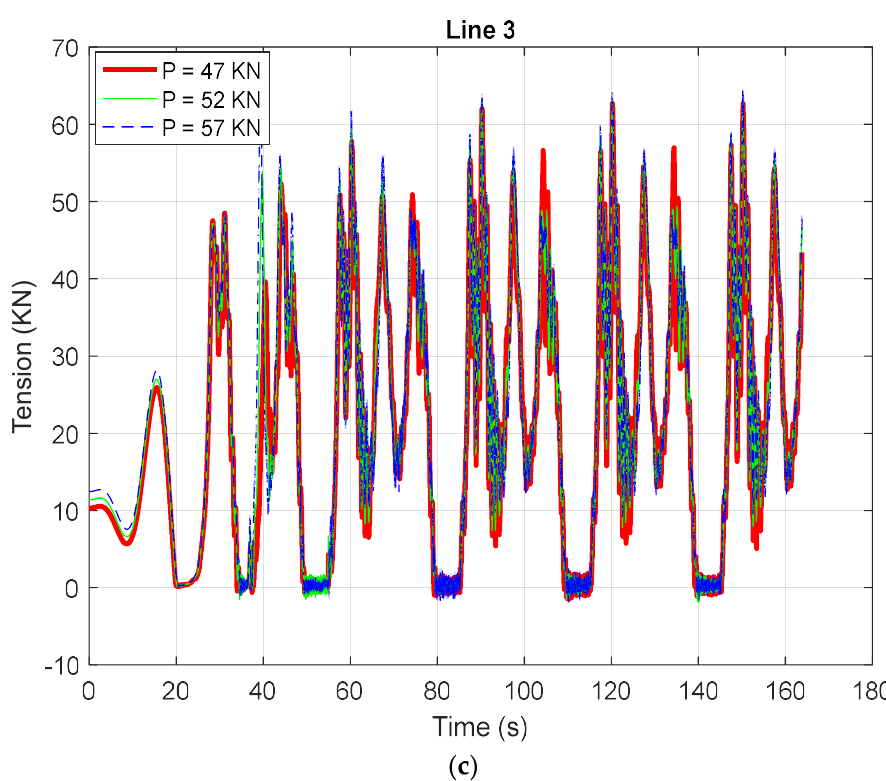
Figure 12. Time series of mooring tension at the fairlead with variations in pretension, ( a ) Line 1 ( b ) Line 2, ( c ) Line 3. Table 8. Comparison of mooring tensions at the fairleads of foundations with different pretension loads.